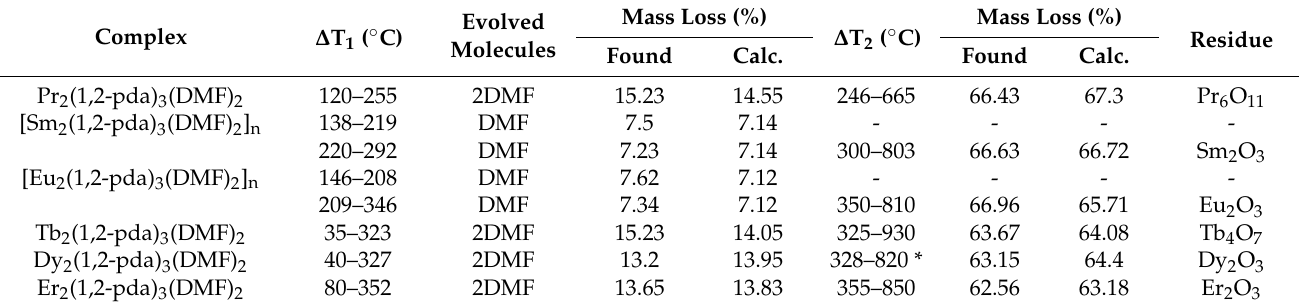
Table 3. Thermogravimetric data obtained during heating of lanthanide(III) 1,2-phenylenediacetates in air.